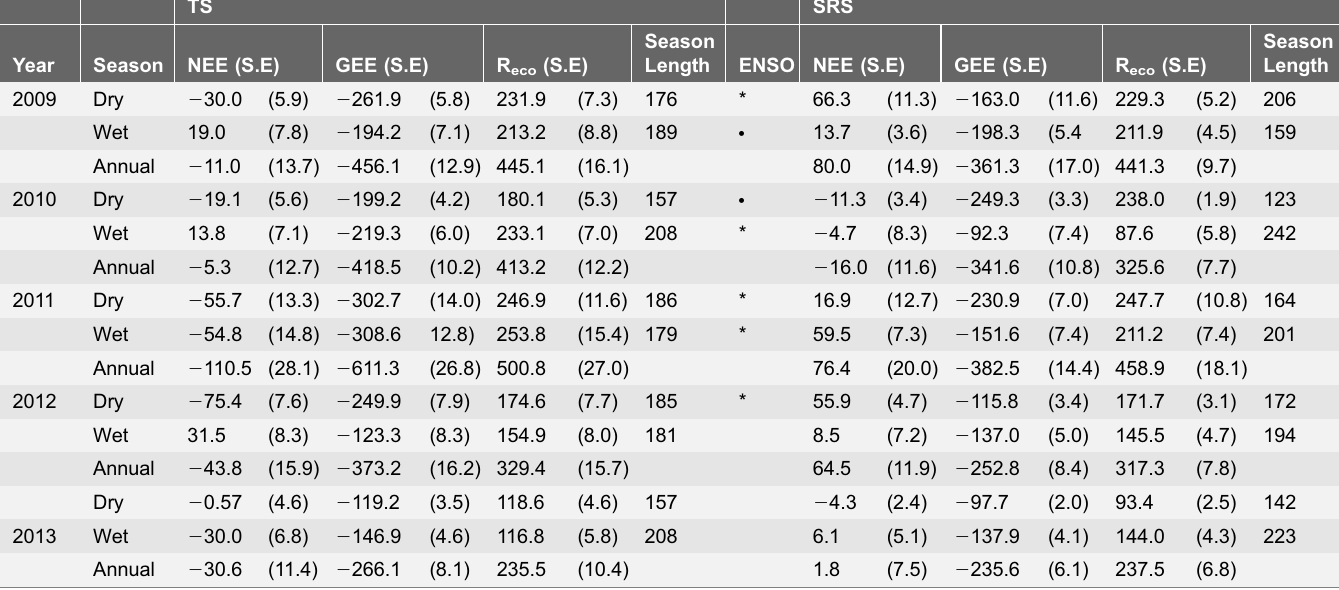
Table 2. Seasonal and annual NEE, GEE, and R eco (g C m 2 2 yr 2 1 ) at Taylor Slough and Shark River